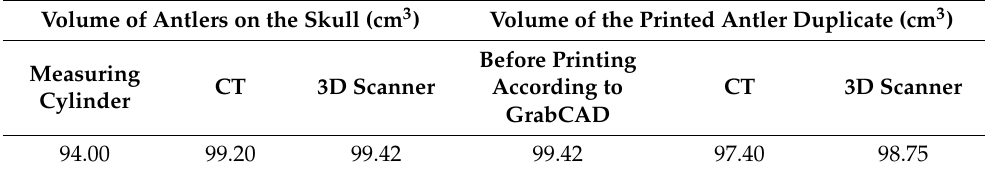
Table 8. Comparison of the measurement of antlers on the skull and the printed duplicate.